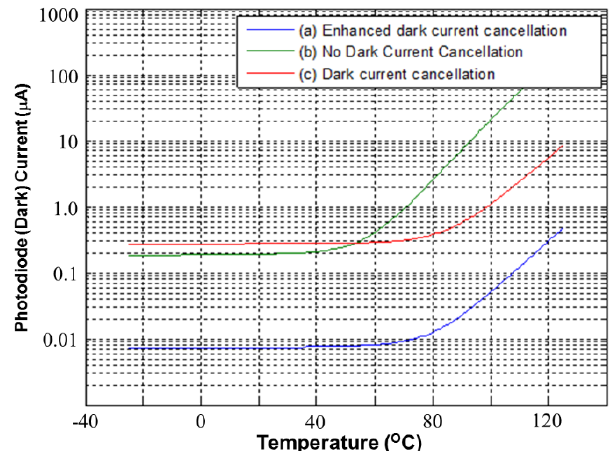
Figure 10. Simulated PD dark currents versus temperatures for various CAs. ( a ) Proposed CA with enhanced dark current cancellation; ( b ) the CA without dark current cancellation; and ( c ) the CA with dark current cancellation.